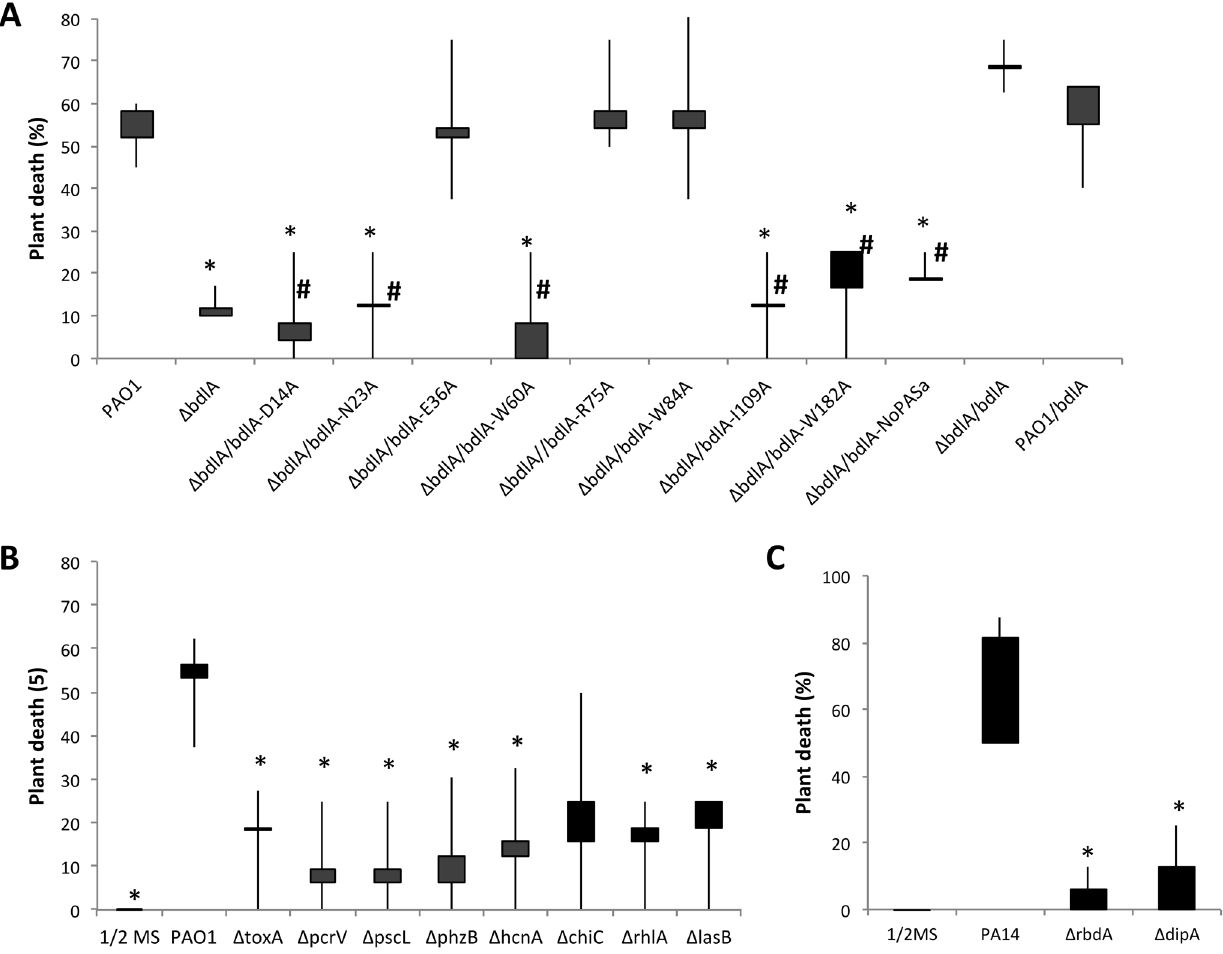
Figure 5. The non-dispersing D bdlA mutant and complemented D bdlA mutants impaired in biofilm dispersion are avirulent. (A) Death of Arabidopsis thaliana 7 days post infection with P. aeruginosa PAO1, the isogenic D bdlA mutant and D bdlA mutants complemented with bdlA , a truncated BdlA variant (NoPAS- bdlA ) and BdlA variants harboring alanine substitutions in various amino acids. # , indicates complemented D bdlA strains impaired in nutrient-induced dispersion, see [58]. All other complemented D bdlA strains were not impaired in nutrient-induced dispersion. (B) Death of Arabidopsis thaliana 7 days post-infection with P. aeruginosa PAO1 and selected isogenic mutants. Bars indicate average and median plant death rates while vertical lines indicate the highest and lowest plant death rates observed. (C) Death of Arabidopsis thaliana 7 days post infection with P. aeruginosa PA14, and the isogenic D dipA and D rbdA mutants. Control plants inoculated with K MS salts alone showed no symptoms over the course of the experiments. Experiments were carried out in triplicate using 8 plants per strain per replicate. *, significantly different from PAO1, P- value , 0.05.